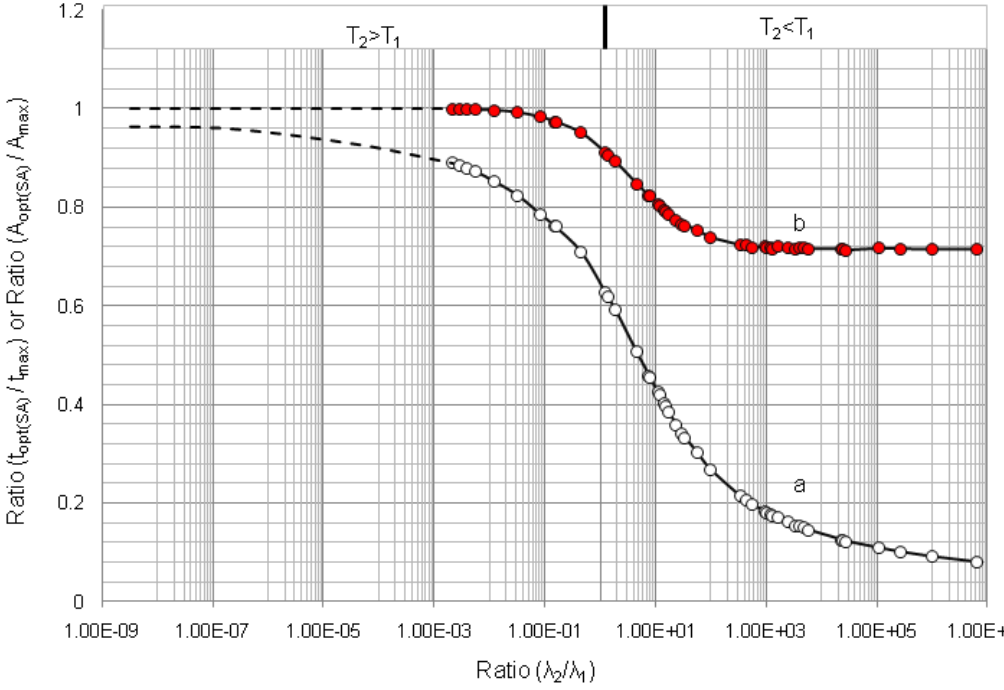
Figure 10. Optimal build-up time t compared with t ( λ / λ ): (a) Ratio ( t 2 1 the parent and daughter nuclides, respectively.